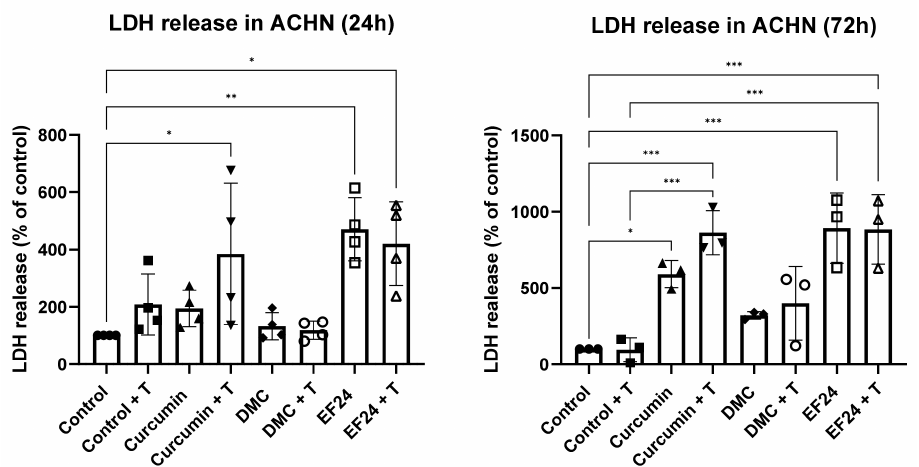
Figure 3. LDH release in ACHN after 24 h treatment with curcumin, DMC or EF24 individually or in combination with TRAIL. Compared to control, there was a significant increase in LDH release in cells treated with curcumin + TRAIL (385.23%) and EF24 (470.53%), both individually and in combination with TRAIL (420.59%). After 72 h treatment, all treatments increased LDH release, and was significant in cells treated with curcumin (590.87%), curcumin + TRAIL (862.89%), EF24 (891.70%) and EF24 + TRAIL (83.08%). 24 h n = 4; 72 h n = 3. * p < 0.05, ** p < 0.01, *** p < 0.001.